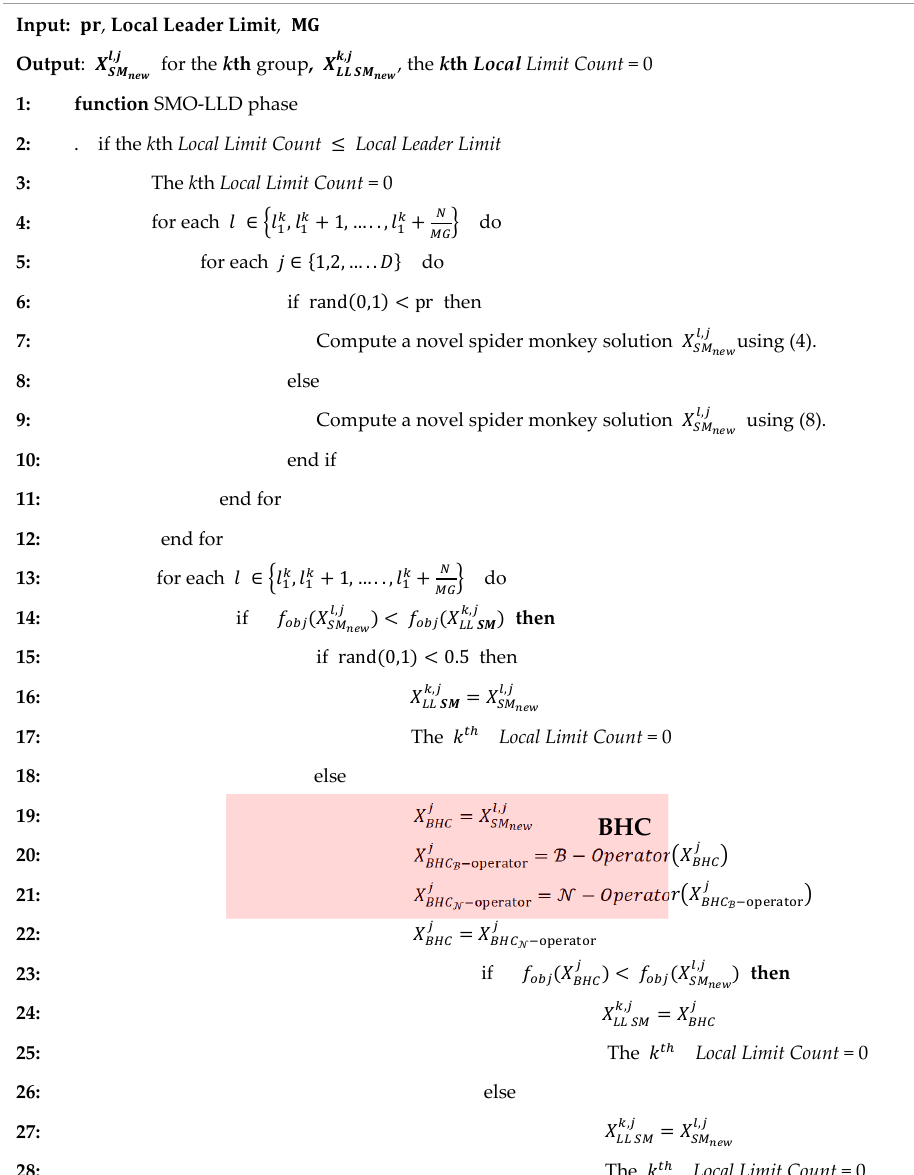
Algorithm 7 : Local Leader Decision (LLD) phase based on BHC